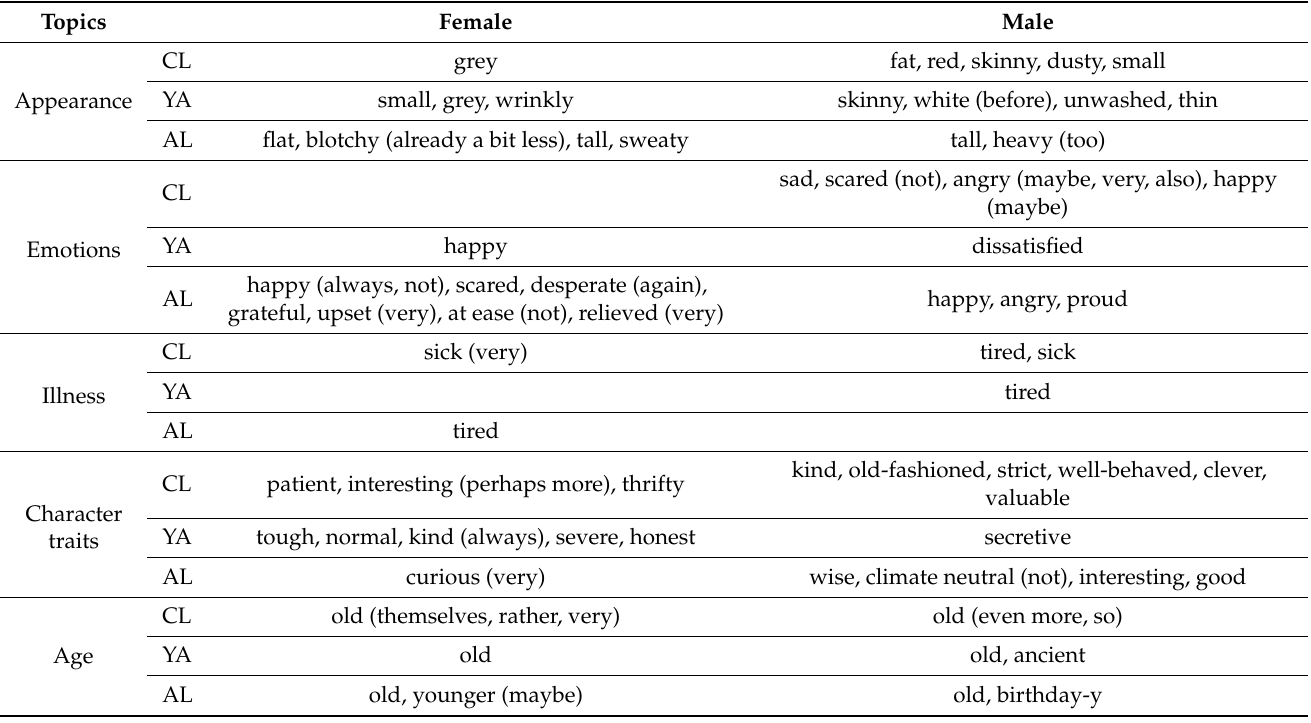
Table A4. Word lists of adjectives associated with female and male older adult characters in